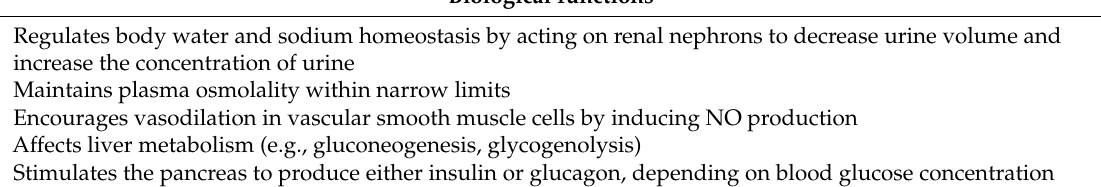
Table 5. Research findings that illustrate the dynamic complexity of AVP, a peptide hormone produced in the hypothalamus a .